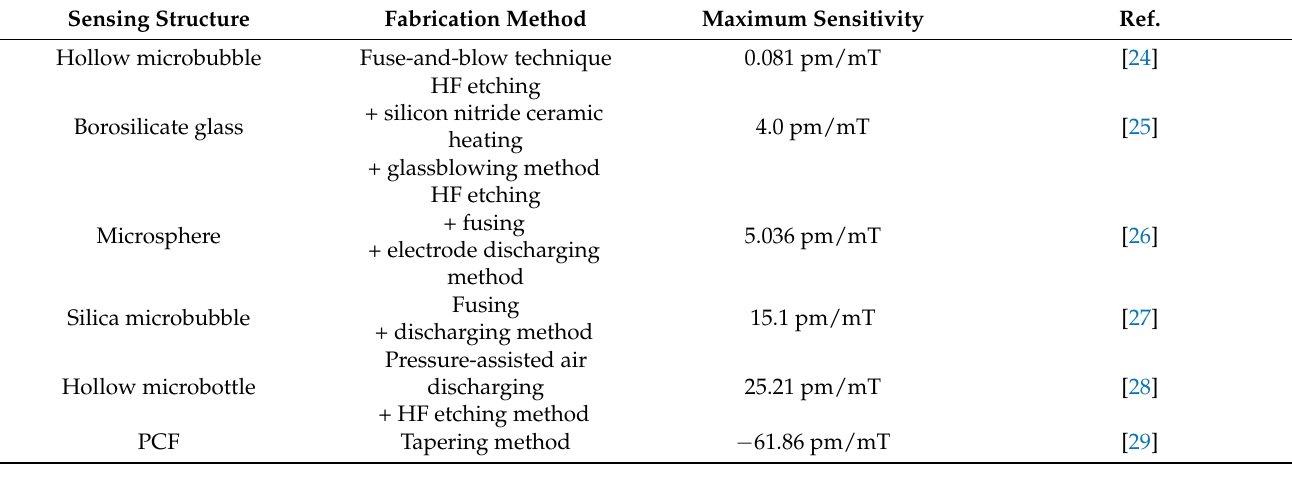
Table 1. Sensing performance of various optical fiber WGM magnetic field sensors.